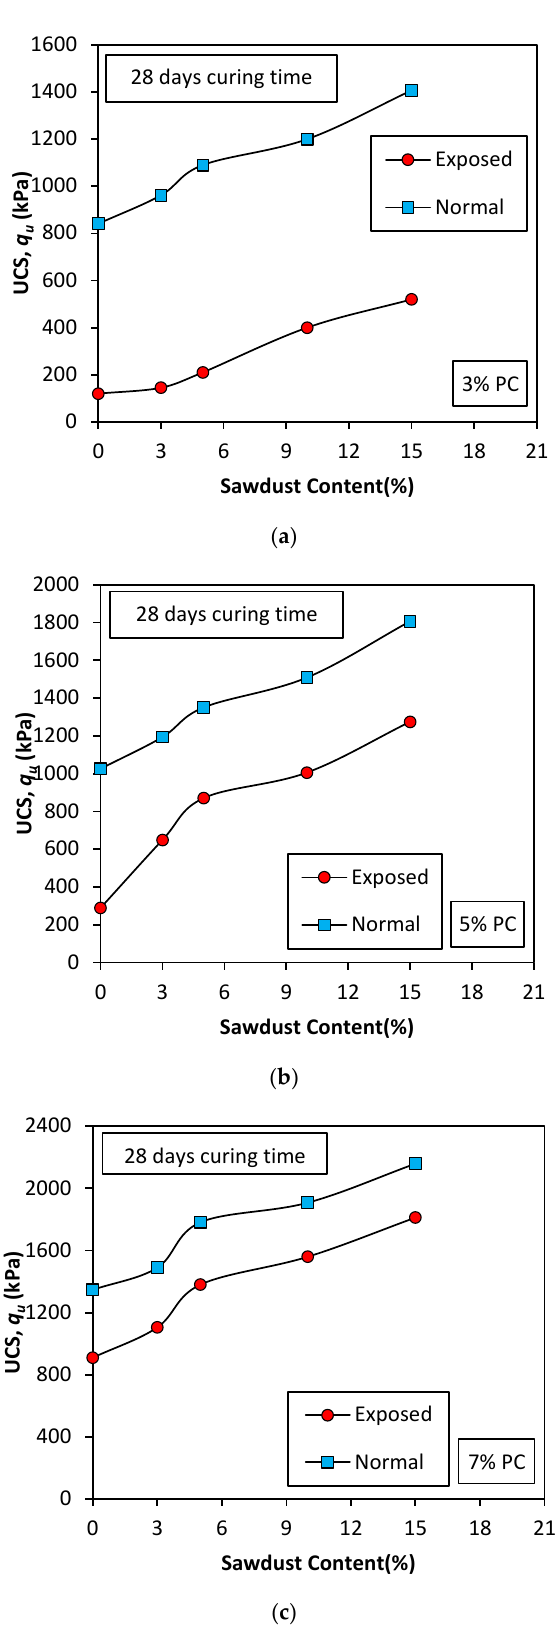
Figure 8. E ff ect of sawdust addition on USC peak values (28 days curing): ( a ) 3% PC; ( b ) 5% PC; ( c ) 7%